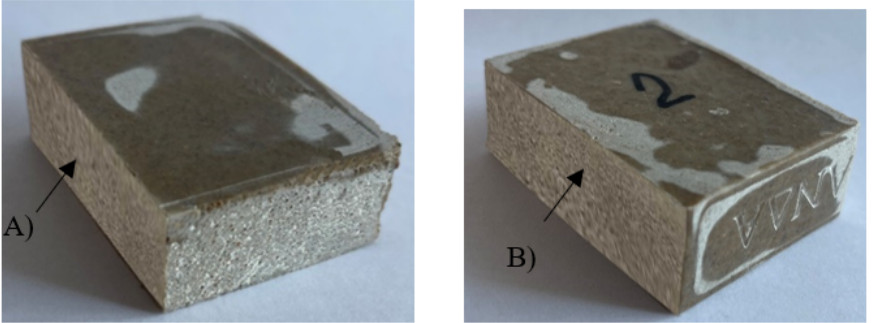
Figure 8. The result of coating a single sample of polymer concrete. ( A ) Coating based on powdered alloy MetaCeram 28010—Cr 2 O 3 in a single sample of polymer concrete (composition No. 23); ( B ) coating based on powdered alloy SF PE 8215—Ni-7Cr-3Fe + 60% WC in a single sample of polymer concrete (composition No. 23).